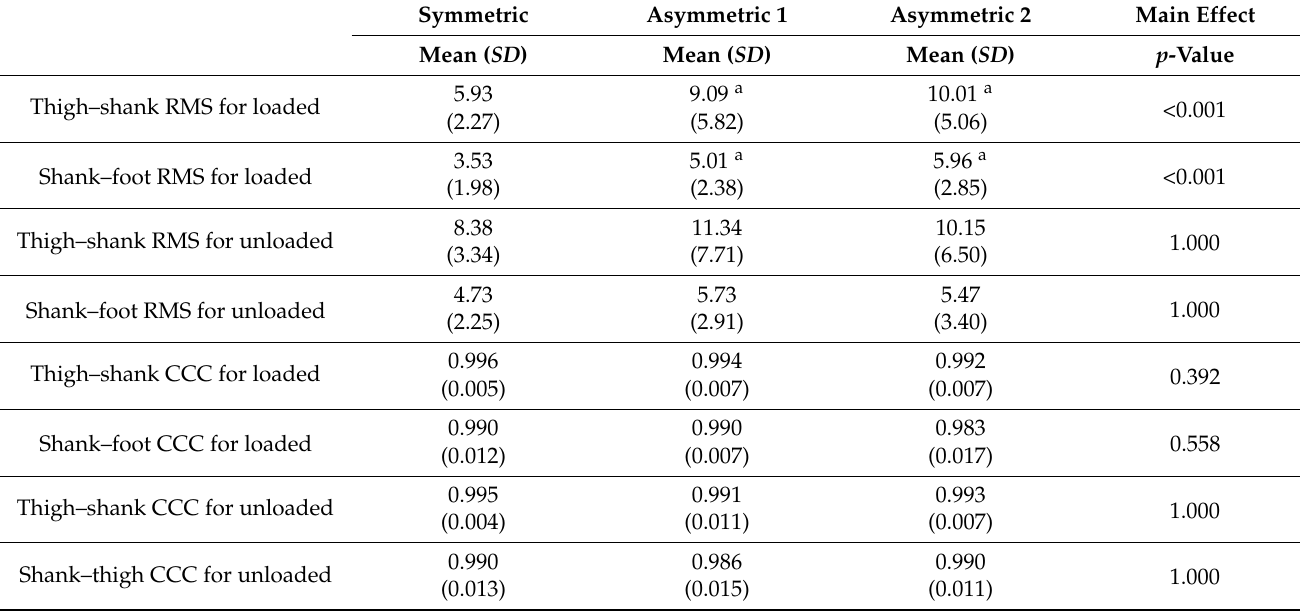
Table 1. Root mean square (RMS) difference and cross-correlation coefficient (CCC) for thigh-shank and shank-foot couplings (intralimb coordination) during stance for the loaded side and unloaded side. a p < 0.05 vs. symmetric load. Symmetric Asymmetric 1 Asymmetric 2 Main Effect Mean ( SD ) Mean ( SD ) Mean ( SD ) p -Value